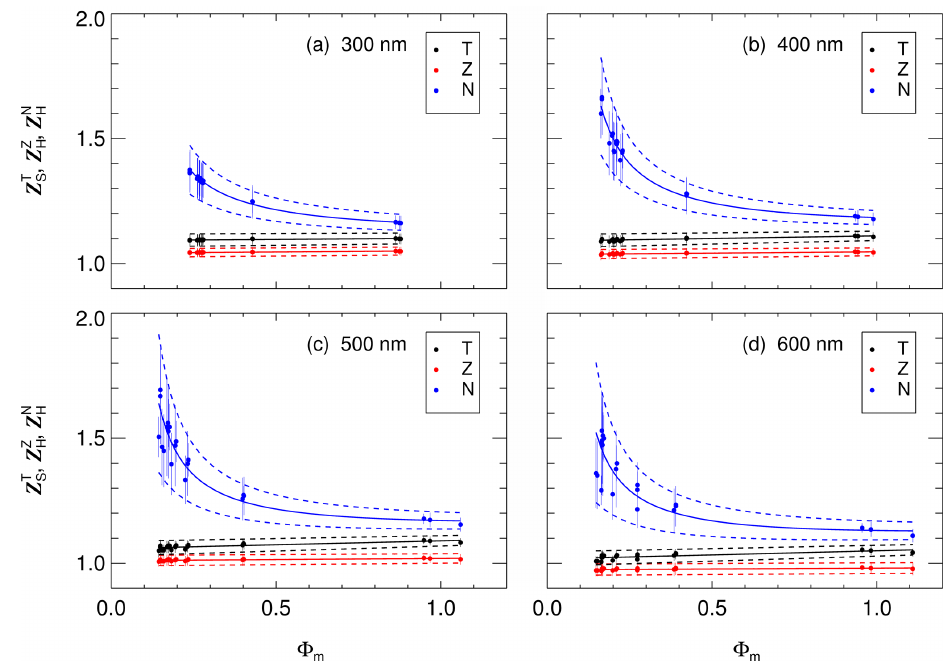
Figure 13. Correction functions Z T (T), Z Z (Z) and Z N (N) for the Zeppelin at an altitude of 1km, a solar zenith angle of 40 ◦ and selected H H S wavelengths in panels (a) – (d) as a function of (cid:56) m (ratio of uncorrected upward/downward spectral actinic flux densities). Data points with error bars show the results for all relevant atmospheric scenarios (Table S1). Full lines are parametrizations, with estimated uncertainty ranges indicated by the dashed lines.